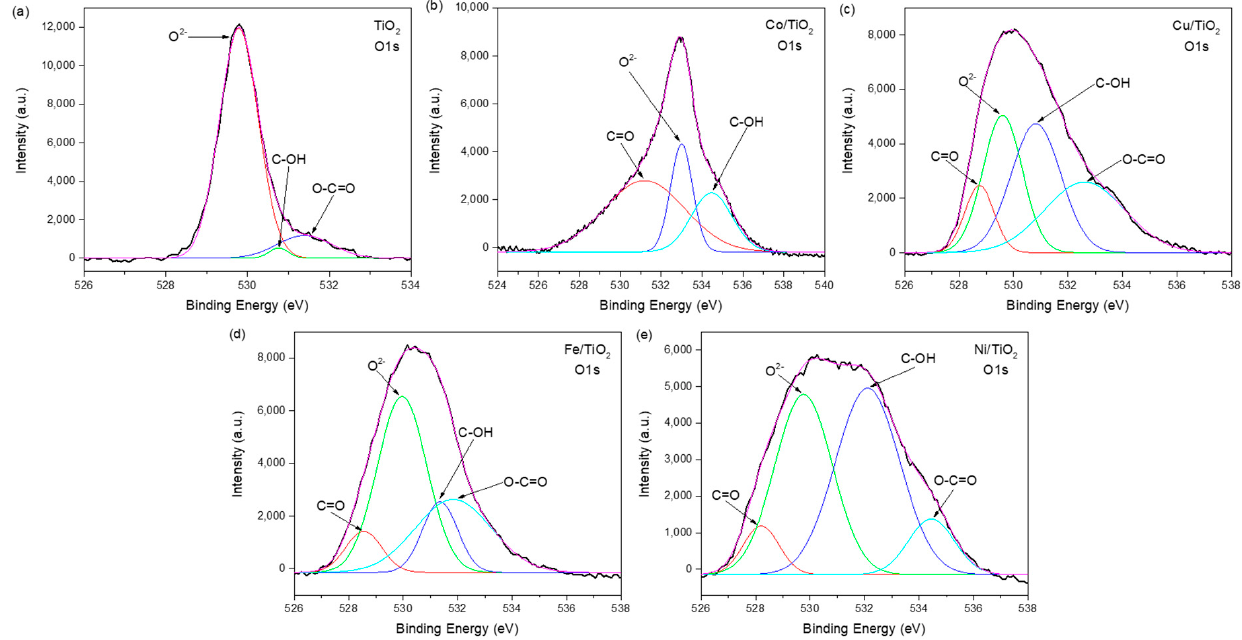
Figure 10. O 1s XPS spectrum of: ( a ) TiO 2 , ( b ) Co/TiO 2 , ( c ) Cu/TiO 2 , ( d ) Fe/TiO 2 and ( e ) Ni/TiO 2 . On the other hand, the presence of C in the XPS spectra resulted from the organic compounds used during the deposition–precipitation method, indicating the addition of ions elements during this processes. The principal peak (C-C) of C 1s spectra (Figure 11) shows signals from about 284.77 (TiO 2 ), 285.09 (Co/TiO 2 ), 284.84 (Cu/TiO 2 ), 284.11 (Fe/TiO 2 ), and 285.23 eV (Ni/TiO 2 ). The C 1s shows the C=C chemical state at 283.81, 283.31, 284.05, 283.22, and 283.71 eV, respectively. The C-OH group appears at 285.35 (TiO 2 ) and 285.43 eV (Fe/TiO 2 ). The peaks at 286.09 (Cu/TiO 2 ) and 286.72 eV (Ni/TiO 2 ) correspond to group C-O-O. The peaks assigned at 287.46 (Co/TiO 2 ) and 289.06 (Fe/TiO 2 ) are attributed to group C=O. In addition, peaks at 288.53 (TiO 2 ), 288.75 (Cu/TiO 2 ) and 288.33 eV (Cu/TiO 2 ) were related with group O-C=O. These results are similar with those reported by Feng et al. [80] and Dougherty et al. [78].